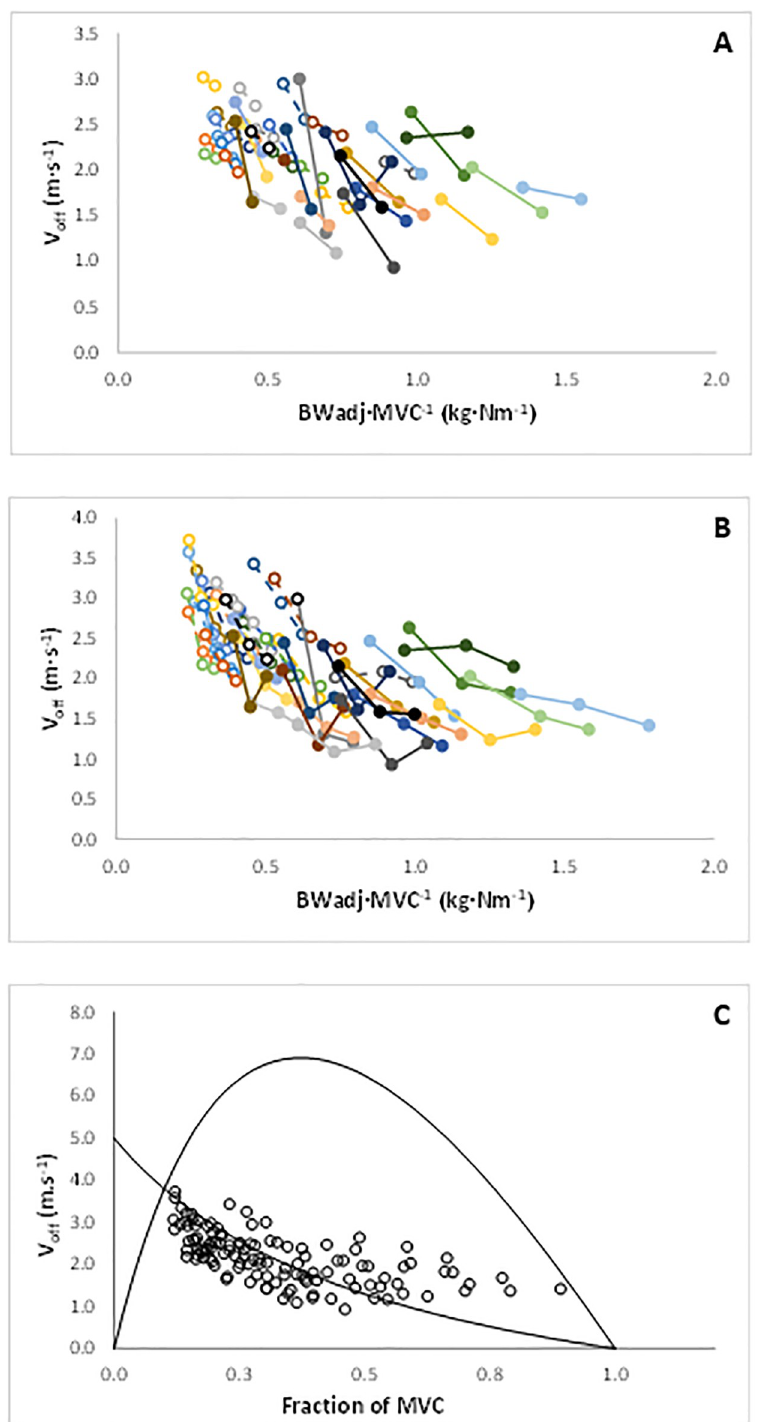
Fig 4. Take-off velocity (V off ) as a function of adjusted body weight divided by maximal voluntary isometric torque (BW adj � MVC -1 ) in A) normal and loaded young (open symbols and dashed lines) and normal and unloaded old (closed symbols and solid lines) participants and in B) added the unloaded young and loaded old data. Black lines and open and closed symbols indicate the average for young and old, respectively. C) To fit the data with least squares analyses to the Hill equation, we divided BW adj � MVC -1 by 2 and found an R 2 = 0.396.